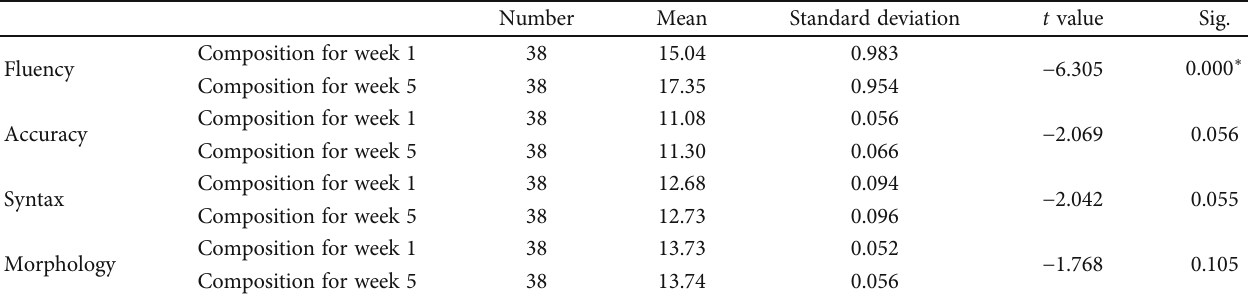
Table 3: Paired sample test: comparison of the fi rst draft and the fi fth draft of the control